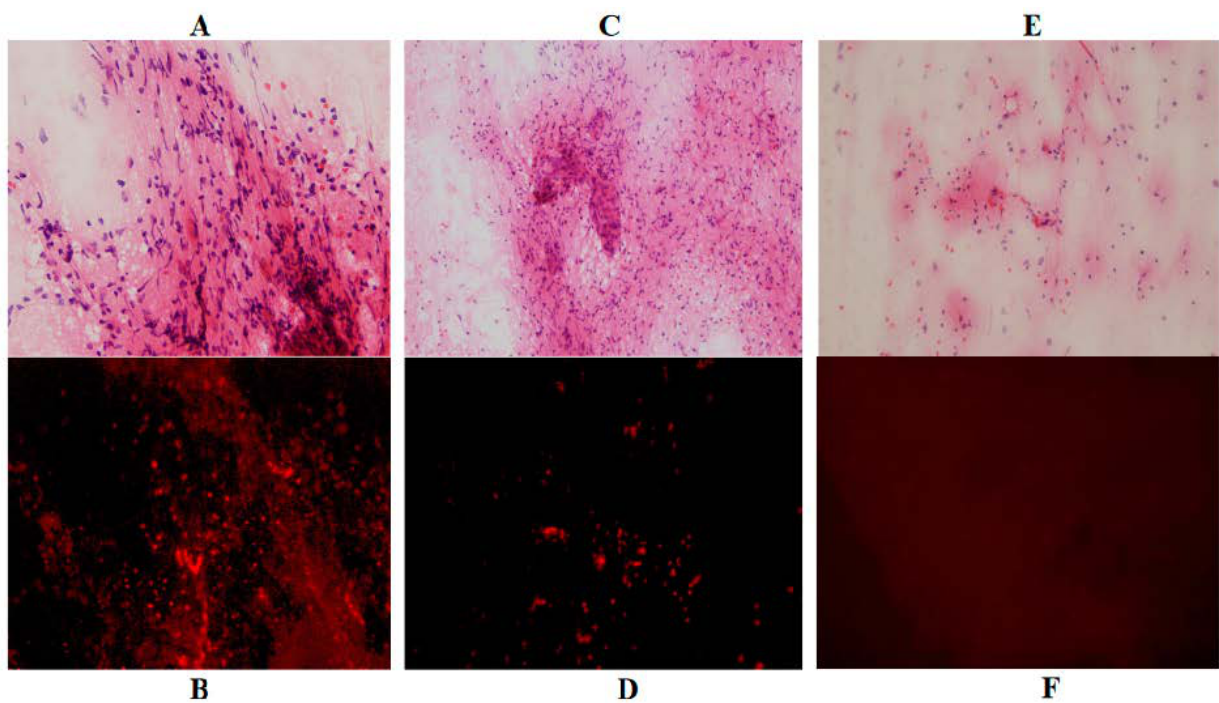
Figure 3. Intraoperative detection of fluorescence emitted from tumor tissues and adjacent brain tissue. ( A – C ) Hematoxylin and eosin staining of crush smear tissue samples of the tumor bulk ( A ); marginal area of the tumor ( B ); and adjacent edematous brain tissue ( C ). ( D – F ) Fluorescence images under the Cy 5 filter system. A total of 208 cells emitting strong fluorescence were detected in the tissue of tumor bulk ( D ); 114 cells were detected in the tissue of marginal area ( E ); and only a few cells were detected in the adjacent brain tissue ( F